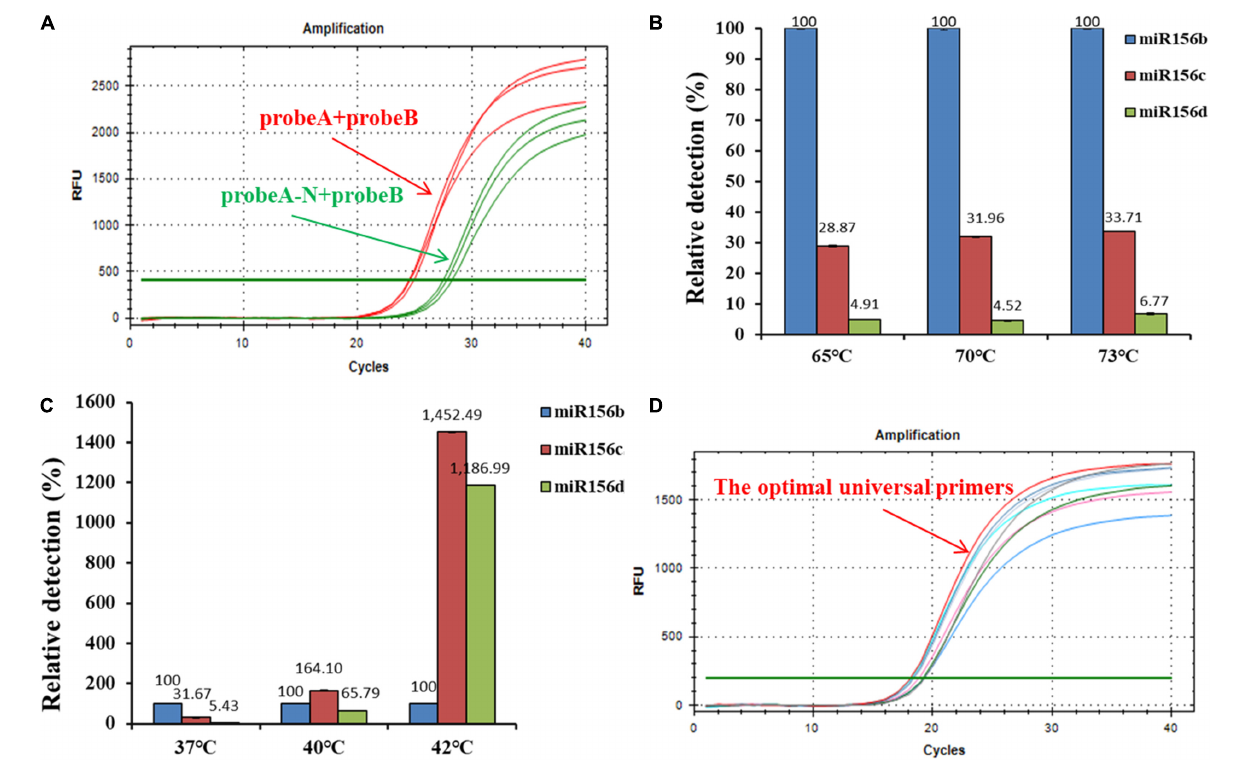
FIGURE 2 | Optimization of ligation-based assays. (A) Analytical performance of deoxyribonucleic acid (DNA) probes modified with two ribonucleotides for reaction efficiency; probe A-N was a control probe without any ribonucleotide modification at its 3 (cid:48) -termini. (B) Effect of hybridization temperature on detection specificity. (C) Effect of ligation temperature on detection specificity. (D) Screening of optimal universal primers for amplification assays; red line: universal primer with the lowest GC content.